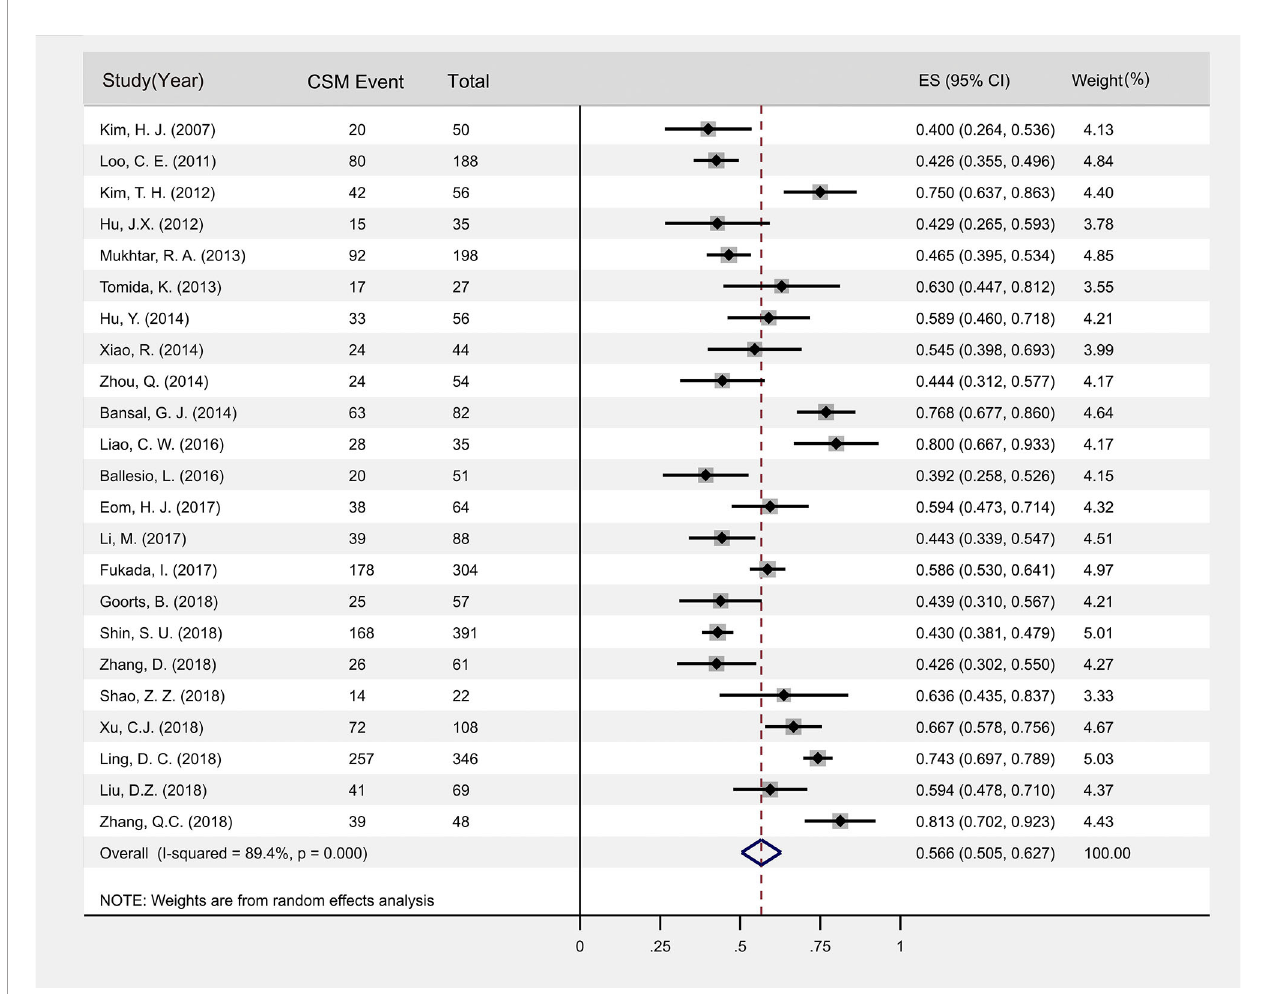
FIGURE 2 | Forest plot of the incidence of CSM after NAC. Pooled estimate incidence of CSM based on 23 papers providing data from 2434 tumors; CSM, concentric shrinkage mode; CI, con fi dence interval; ES, effect